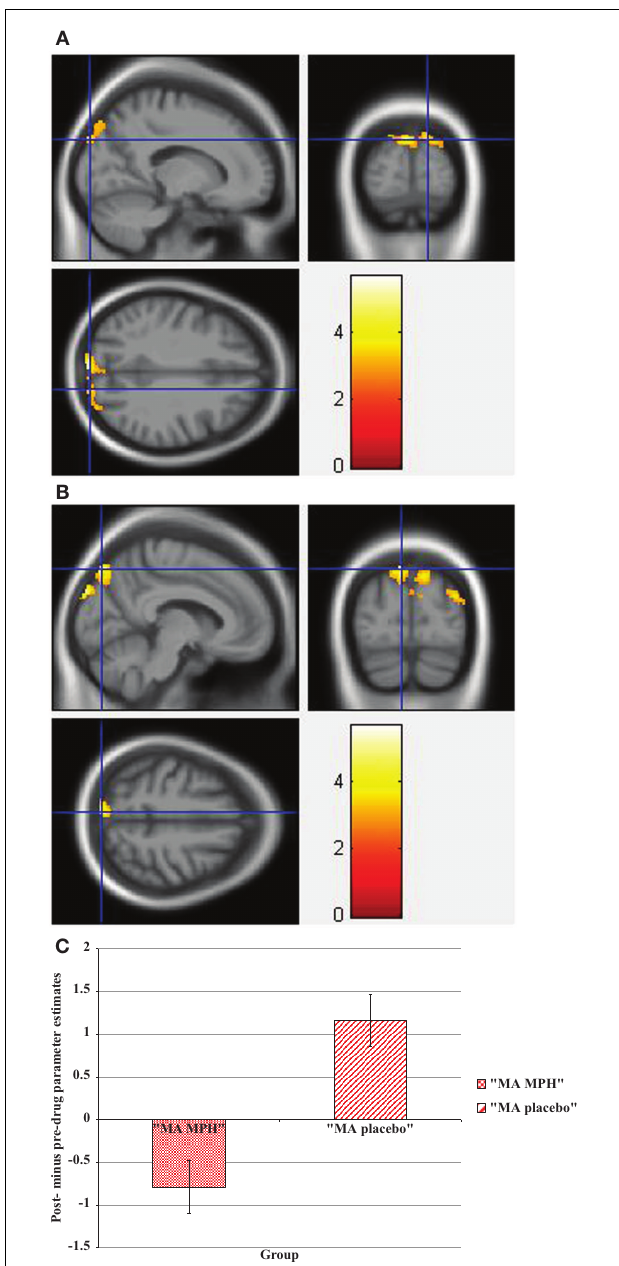
FIGURE 3 |Whole-brain 2 × 2 between-subjectANOVA results for the incongruent condition showing post- minus pre-drug “MA placebo” > “MA MPH” group differences in activation of: (A) the right superior occipital gyrus [peak voxel MNI co-ordinates (mm): (17, − 92, 34); T 29 = 3.53, p < 0.05 cluster-corrected], (B) the left superior parietal gyrus [peak voxel MNI co-ordinates (mm): ( − 8, − 82, 52); T 29 = 4.49, p < 0.05 cluster-corrected], and (C) Plot of the mean ± standard error parameter estimates representing the percentage blood-oxygen- level-dependent signal change post- compared to pre-drug administration within the left superior parietal gyrus .The scale represents the color (from red to yellow) of the cluster corresponding to the increasing t -statistic.The structural image represents the IXI550 average normal brain which has been registered to the MNI152 space with corresponding inferior–superior co-ordinates.